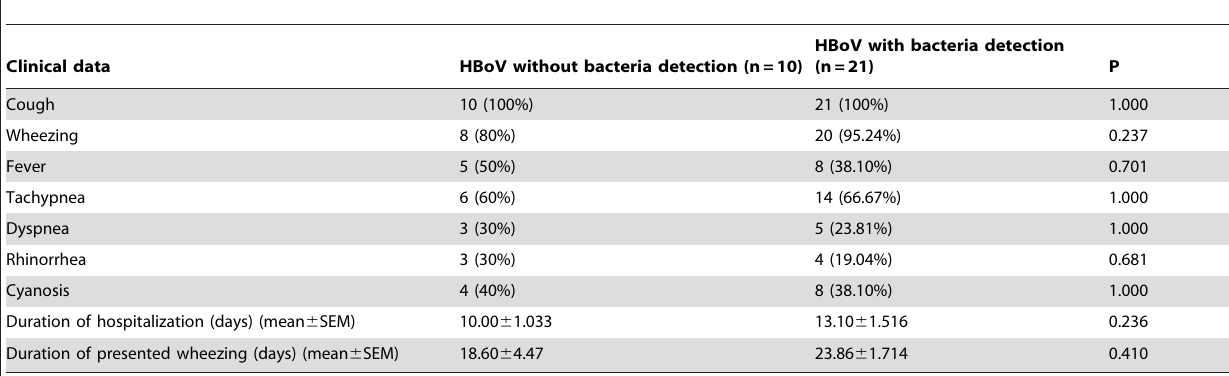
Table 4. Clinical characteristic of children who had HBoV detection with or without detection of bacteria.